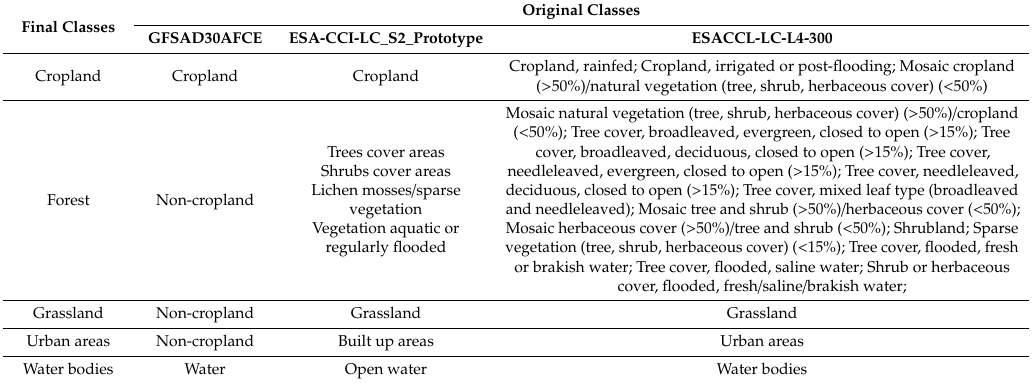
Table 4. Summary of the harmonization process of the di ff erent datasets to the five defined land cover classes used in the